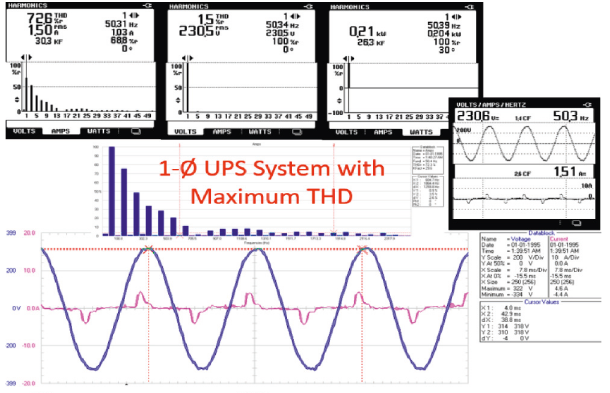
Figure 12: Experimental single-phase UPS system waveforms of voltage, current, and the frequency spectrum of harmonics with maximum Based on these results, Single-phase half-bridge HAPF with fuzzy logic controller-based PWM has been investi- gated particularly for UPS-connected nonlinear loads.